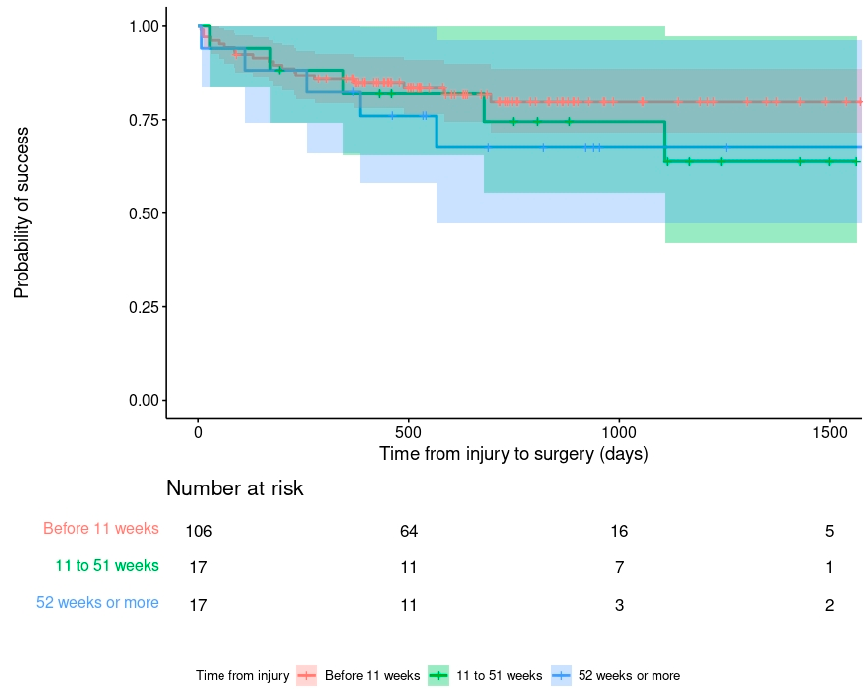
Figure 4. Kaplan–Meier survivorship curve demonstrating the relationship between time from in- jury to FRI surgery and primary outcome in patients having debridement, anti-microbial therapy and implant retention (DAIR).